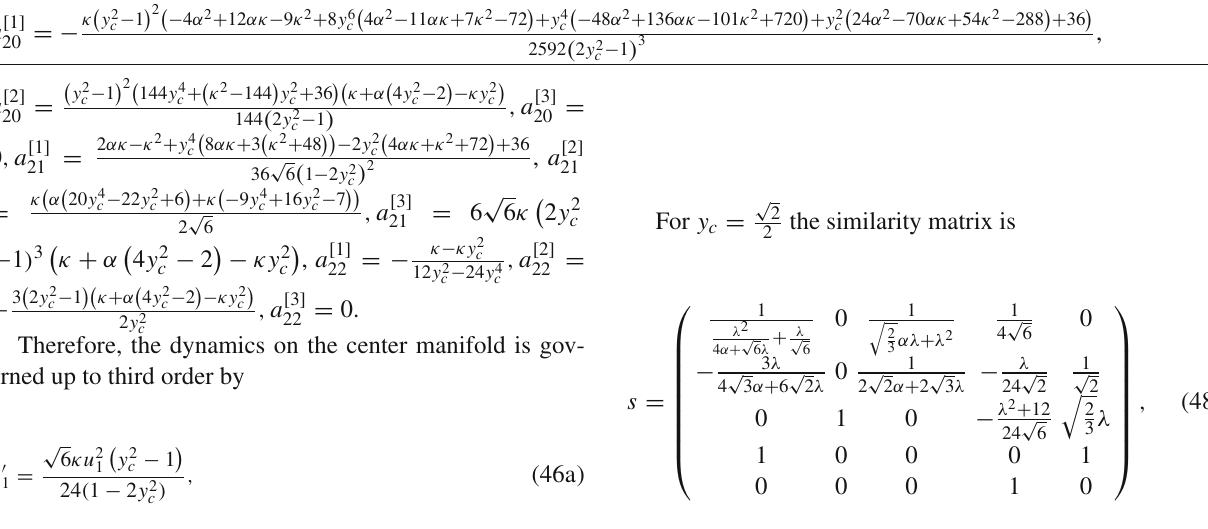
(cid:4) is a saddle 2